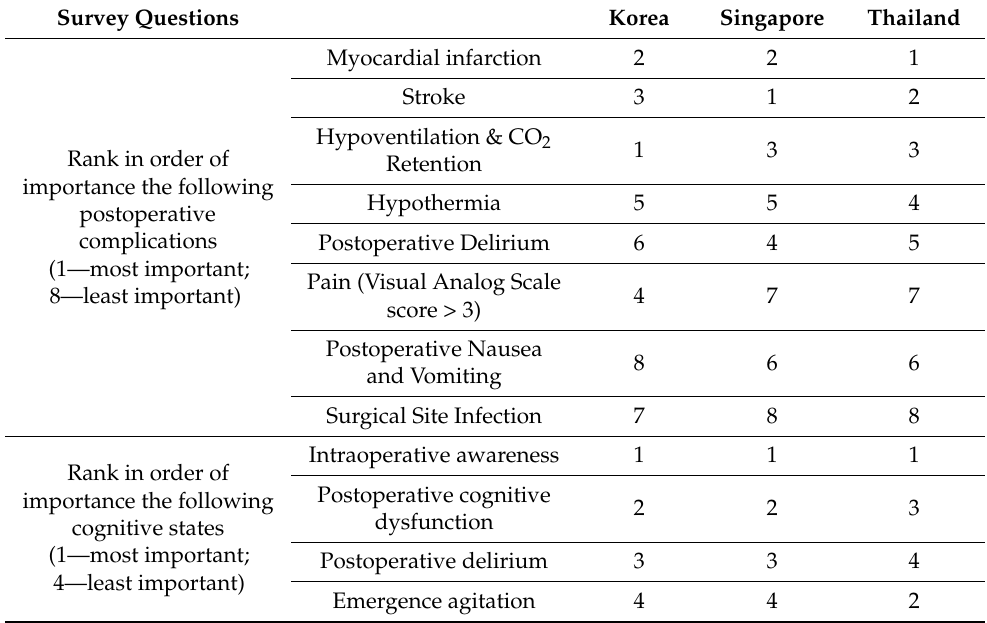
Table 2. Respondents’ rankings for the importance of postoperative complications and cognitive